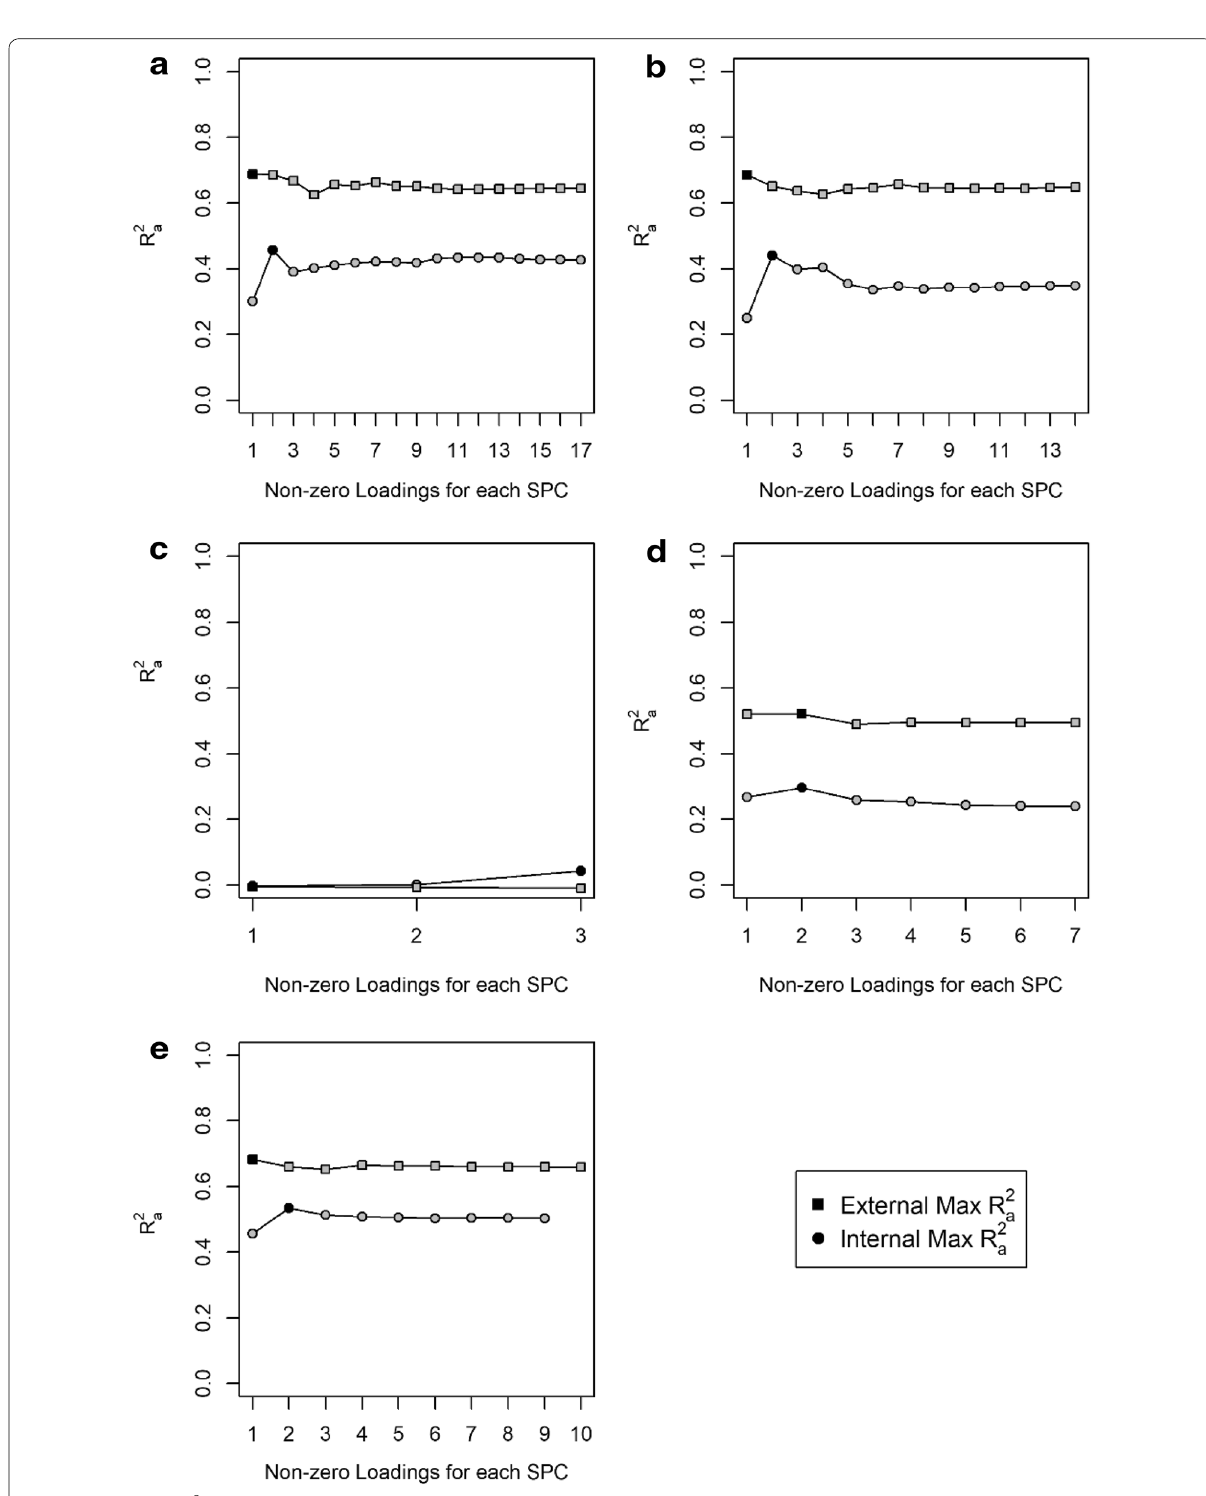
Fig. 3 Plot of SPCA R 2 a against number of non-zero loadings used per PC for a all variables and the b Continuous, c Categorical, d Self-Selected, and e Correlation Cutoff variable subsets. The maximum R 2 a for each model is highlighted with a filled